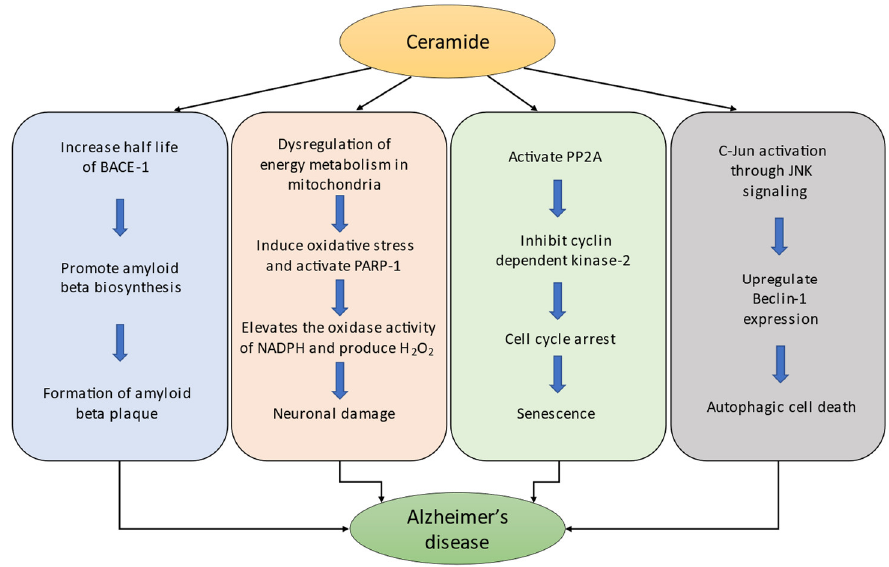
Figure 2. Mechanistic role of ceramide in the pathogenesis of AD.